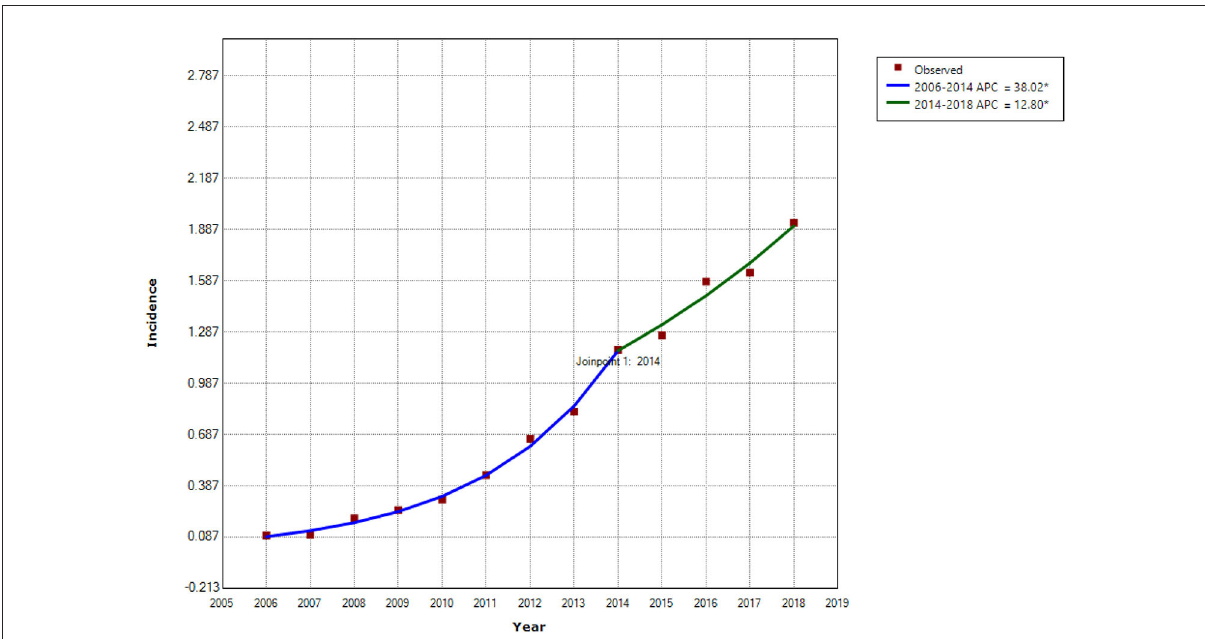
FIGURE2 Trends in incidence of scrub typhus and joinpoints in China from 2006 to 2018. *Statistically significant trends. APC, Annual Percentage Change.